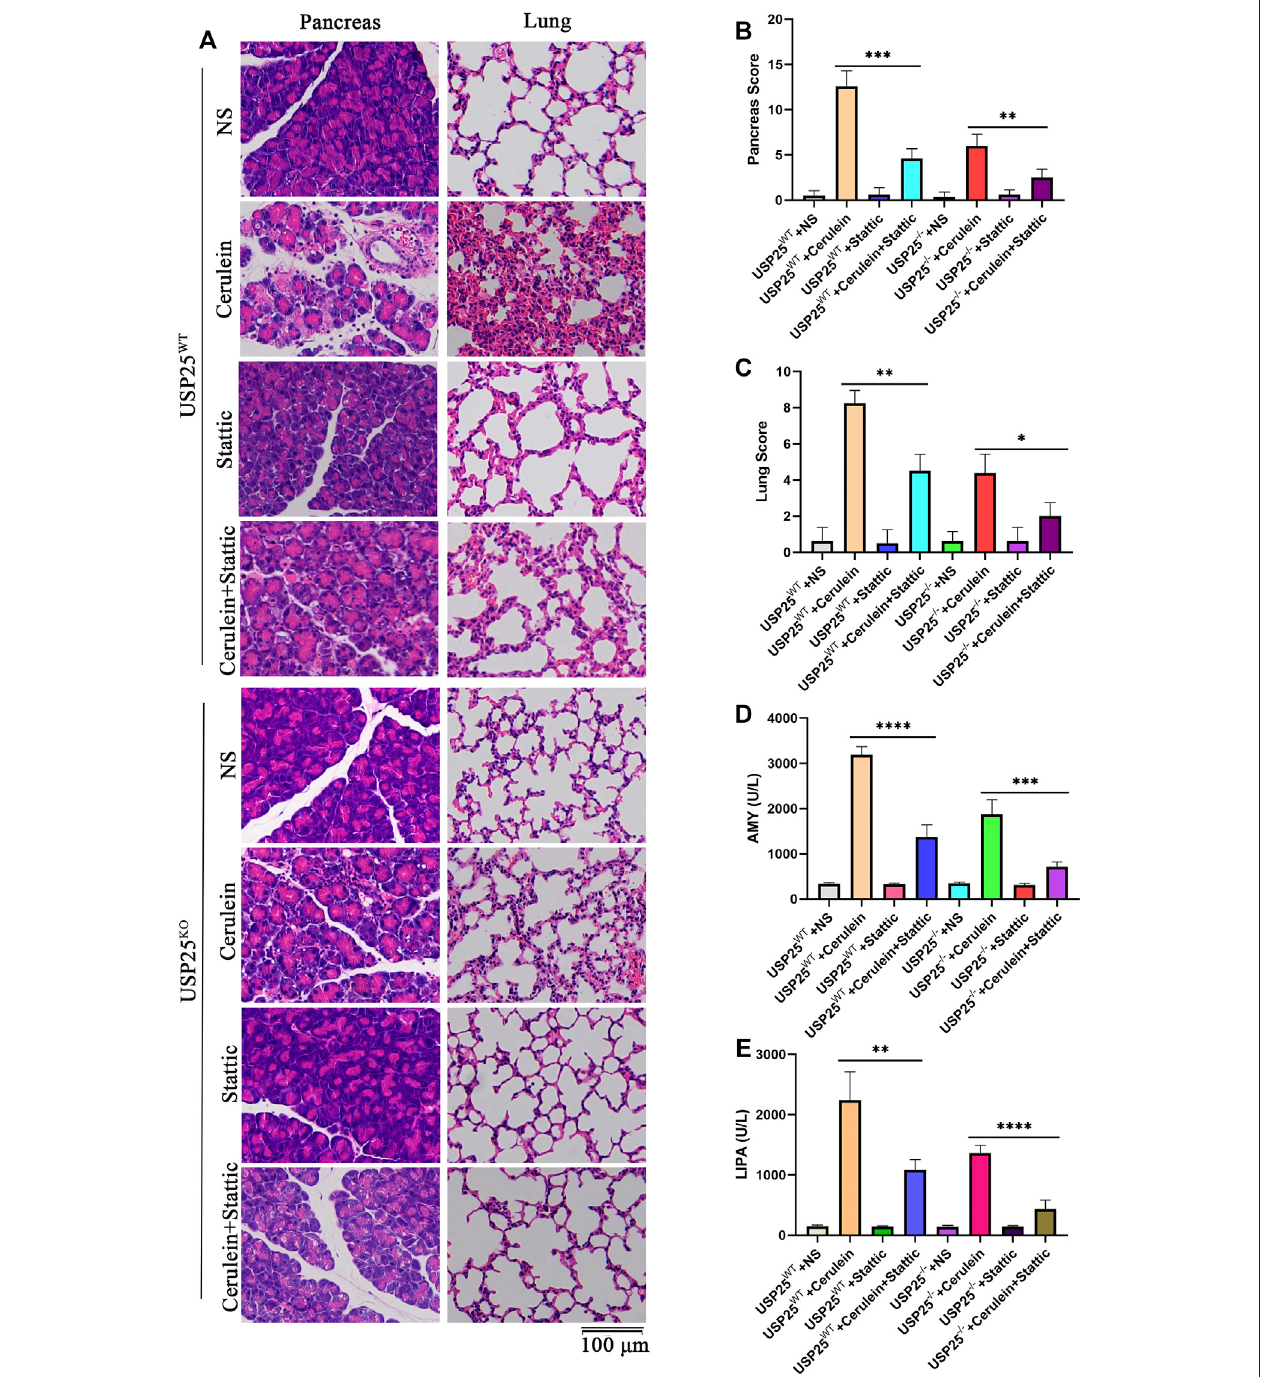
FIGURE6| USP25aggravatesacute pancreatitis andacutepancreatitis-related lunginjurybyactivatingSTAT3 pathway invivo .STAT3(Y705)activationinhibitor- StatticwasusedtointerferewithSTAT3phosphorylationinUSP25 WT andUSP25 − / − mice(n (cid:1) 8pergroup),thenceruleinwasusedtoinduceAPinmice. (A) H&Estaining of pancreas, lung in eight experimental groups. (B – C) The histological scores of pancreas, lung in eight experimental groups. (D – E) Mice serum AMY, LIPA were examined by automatic chemical analyzer in eight experimental groups. *P < 0.05, **P < 0.01, ***p < 0.001 and ****p < 0.0001.